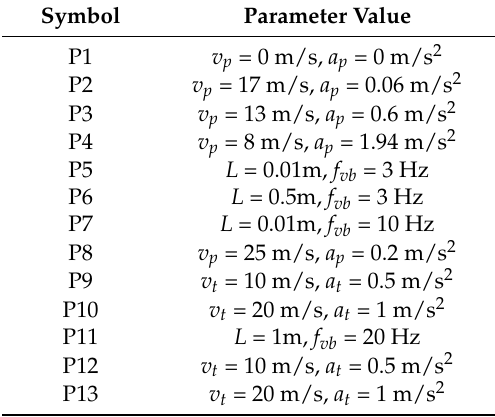
Figure 8. Imaging results with the radar platform displacement parameters P4. ( a ) RD algorithm; ( b ) cross-correlation method; ( c ) minimum entropy method; ( d ) the proposed method. Different parameters from the experiments are listed in Table 2 for a more intuitive view. Table 2. The motion parameters of the radar platform and maneuvering target in different experiments.